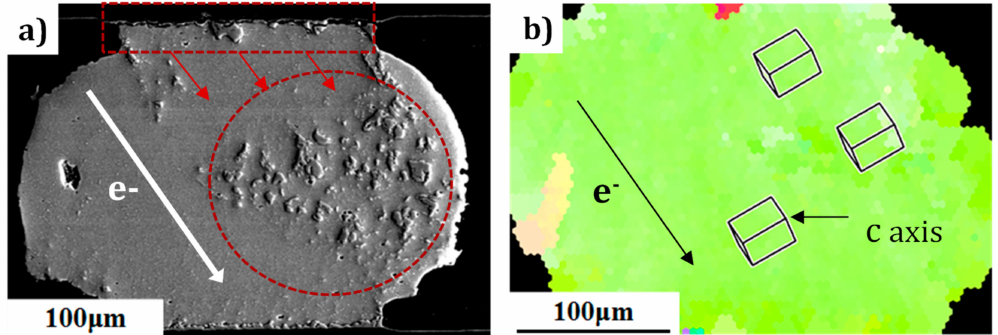
Figure 6. Microstructure images of the microbump with monocrystalline structure stressed at RT. ( a ) SEM images of the Sn3.0Ag0.5Cu microbump after stressing at the current density of 1 × 10 4 A / cm 2 for 163.5 h at RT (25 ◦ C) and ( b ) corresponding inverse pole figure of the microbump in Figure